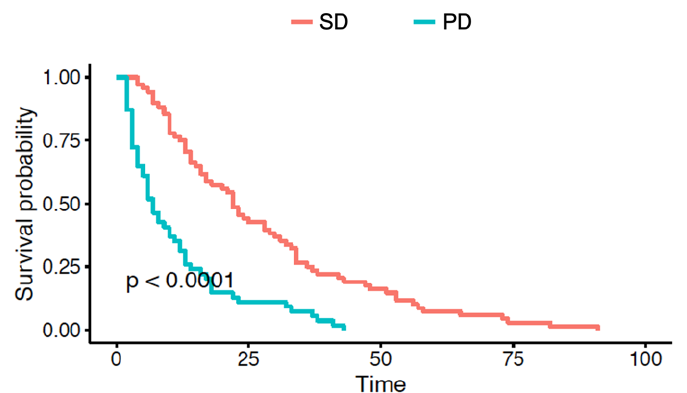
Figure 1. Kaplan–Meier curves representing differences in OS (in months) between patients with early disease progression (PD) and without disease progression (SD) at 3 months after systemic therapy.